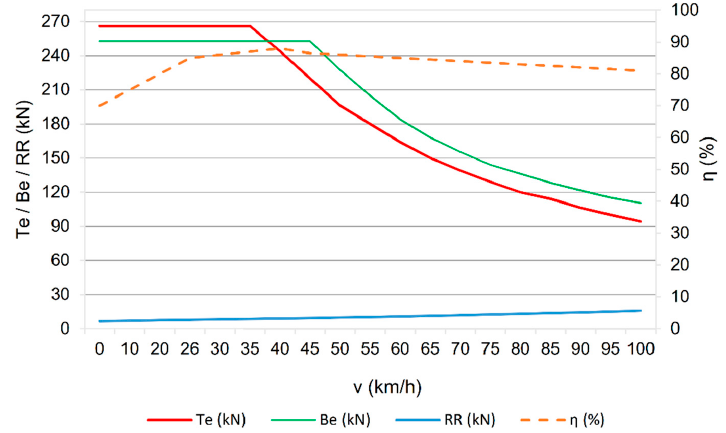
Figure A2. Metro train tractive effort, braking effort, rolling resistance and efficiency as a function of velocity.